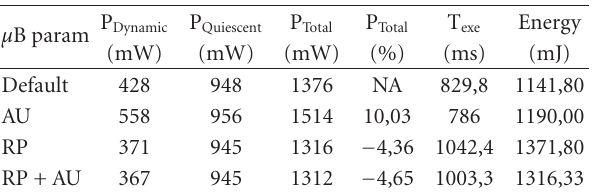
Figure 26: Impact of the MicroBlaze configurations for the ANN algorithm. Table 9: Impact of the MicroBlaze configurations for the Quicksort algorithm at 100MHz for